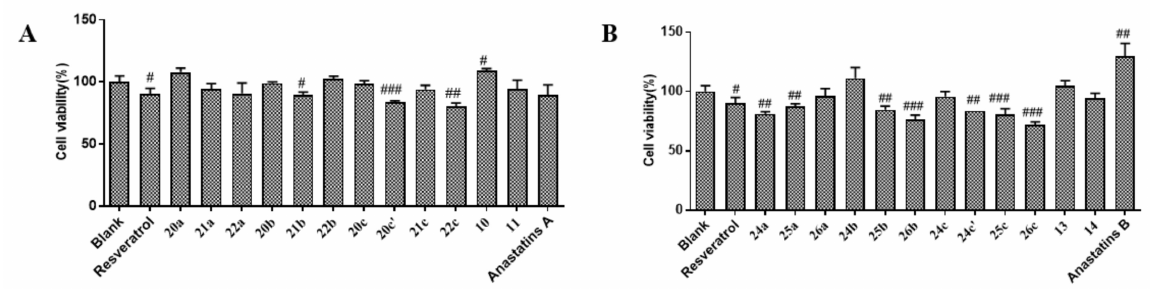
Figure 3. Cytotoxicity of anastatins A and B and their derivatives (10 µ M) to H9c2 cardiomyocytes. ( A ) Cell viability was determined in H9c2 cells treated with anastatin A and its derivatives. ( B ) Cell viability was determined in H9c2 cells treated with anastatin B and its derivatives # p < 0.05; ## p < 0.01; ### p < 0.001 vs. blank.